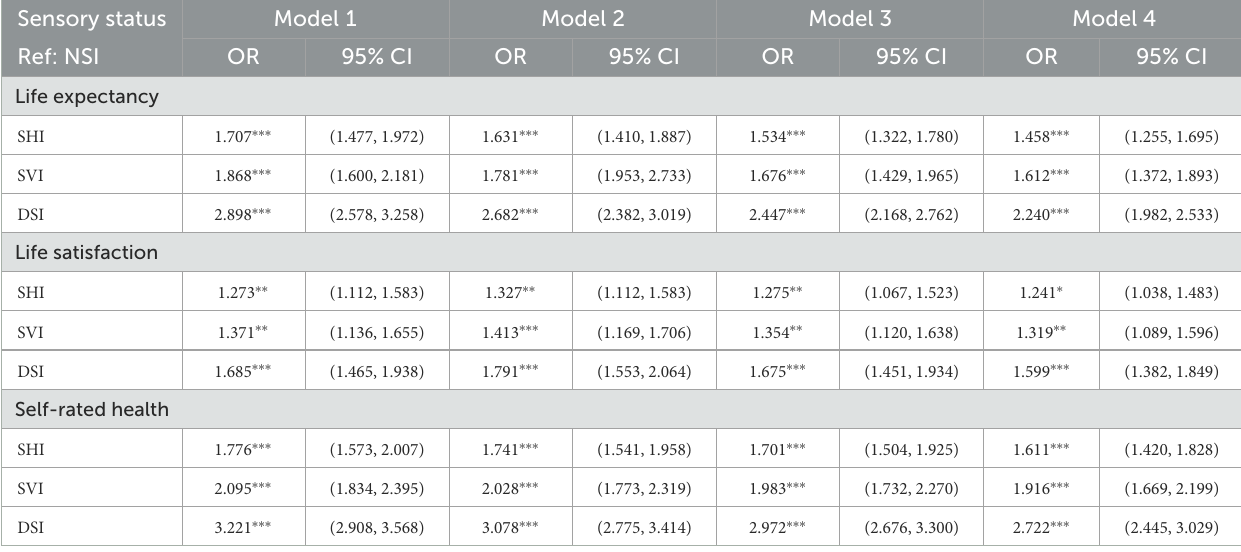
TABLE 2 Cross-sectional logistic regression analyses of sensory impairments and subjective wellbeing